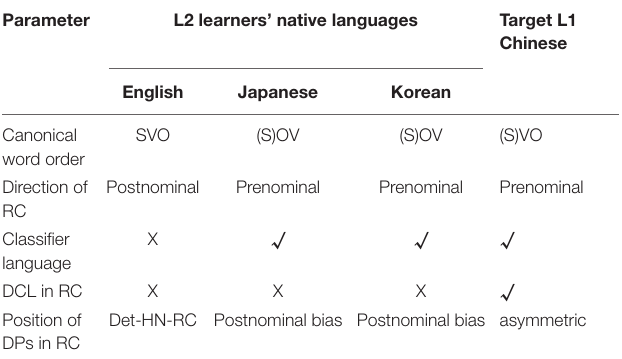
TABLE 1 | Summary of similarities and differences between target L2-Chinese and L2 learners’ native languages. Parameter L2 learners’ native